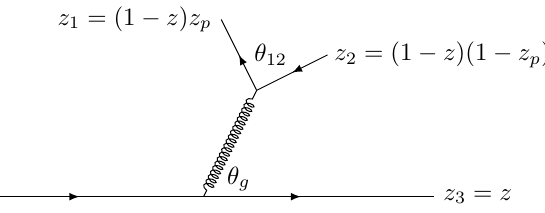
Figure 1 . The Feynman diagram representing gluon decay to a q ¯ q pair, where the quark from the gluon decay is either identical or non-identical to the initiating quark. The mapping of the momentum fractions to a set of independent variables is explained in the